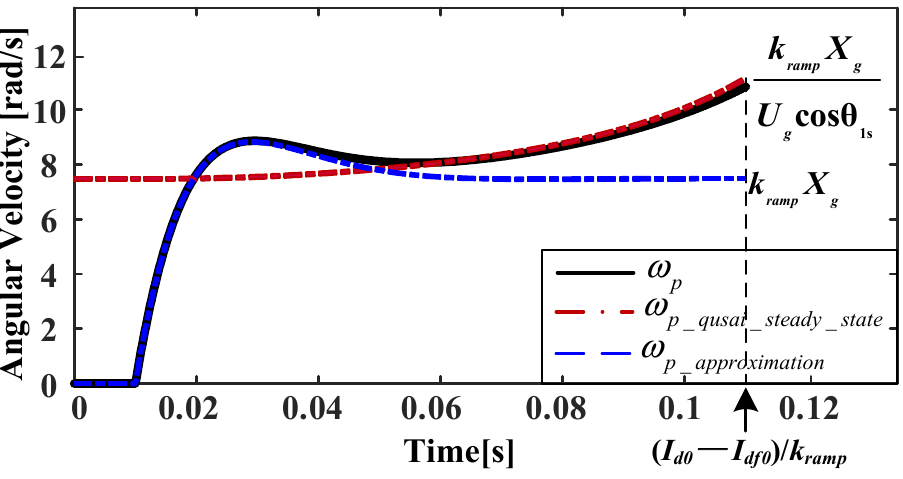
Figure 11. Frequency response of internal voltage dominated by PLL. From Figure 10, active power climbing rate k ramp has much influence on frequency response of internal voltage dominated by PLL. By numerical calculation, the frequency response at different active power climbing rates is shown in Figure 12. It is seen that the frequency offset tends to be large at the end of active power climbing with the increase in active power climbing rate. Since the final state in the stage determines the initial state after active power climbing, it is indicated that the initial state in the second stage will deviate from the equilibrium point far away with the increase in active power climbing rate, which will deteriorate the transient behavior and even bring transient instability issue after active power climbing.